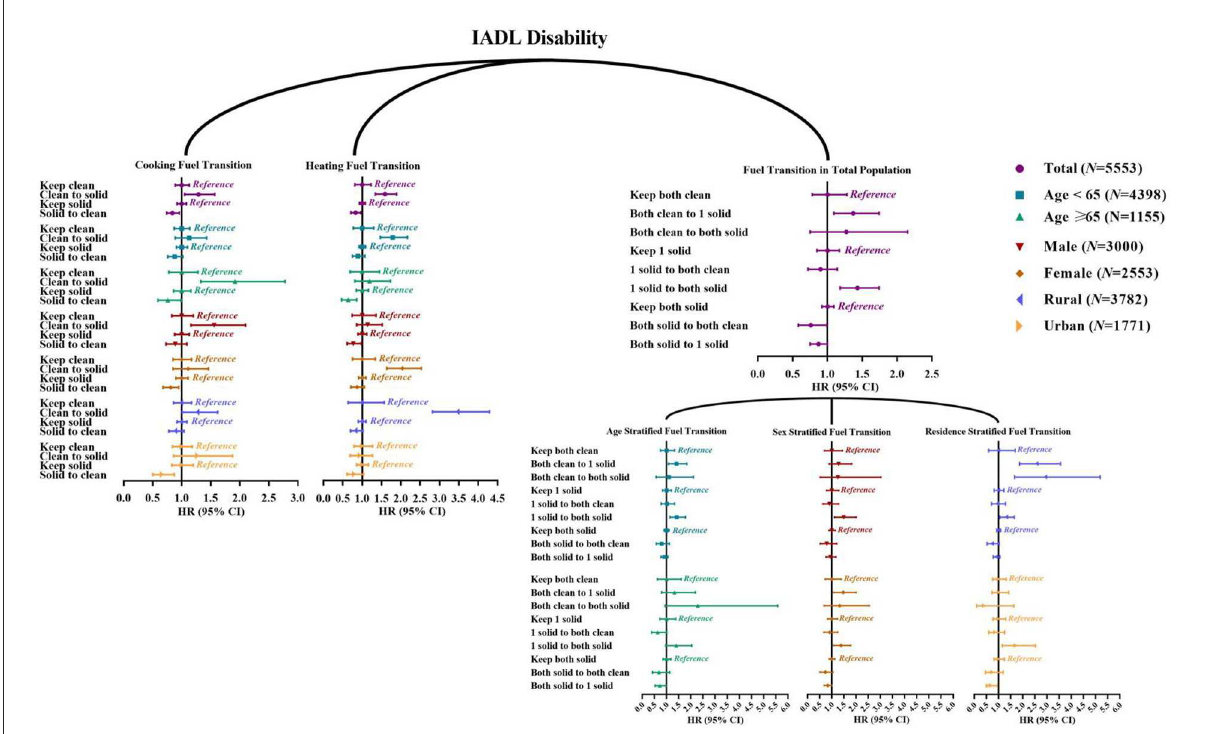
FIGURE3 Hazard ratio (95% confidence interval) of fuel usage transitions with new-onset IADL disability: Cox proportional-hazards model. IADL, instrumental activities of daily living. The reference of “Clean to solid” is “Keep clean;” the reference of “Solid to clean” is “Keep solid;” the reference of “Both clean to 1 solid” and “Both clean to both solid” is “Keep both clean;” the reference of “1 solid to both clean” and “1 solid to both solid” is “Keep 1 solid;” the reference of “Both solid to both clean” and “Both solid to 1 solid” is “Keep both solid”.